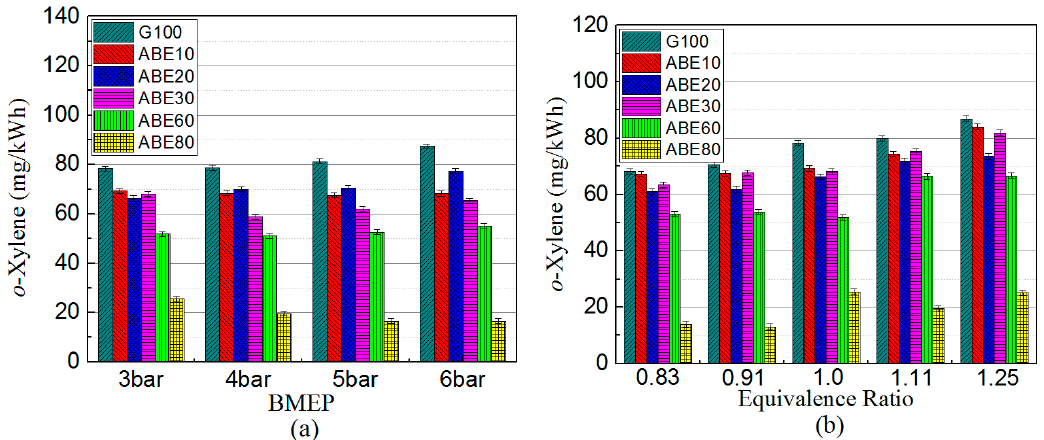
Figure 11. o -Xylene emissions at ( a ) stoichiometric conditions under different BMEP, and at ( b ) 3 bar BMEP under different equivalence ratios.